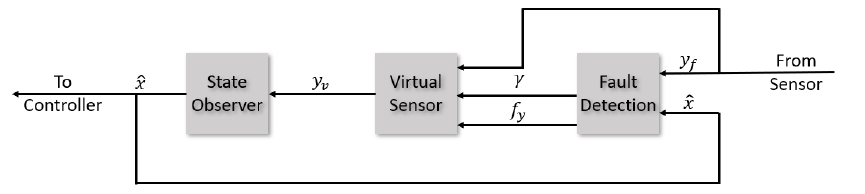
Figure 11. Virtual sensor fault tolerant block